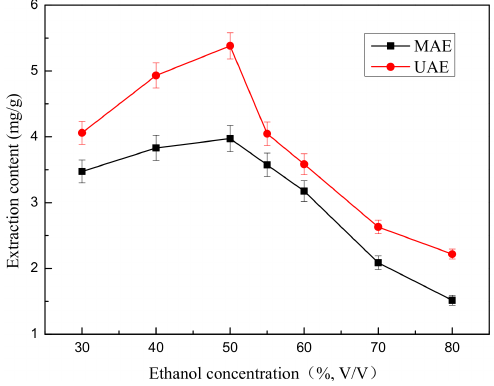
Figure 3. Effect of ethanol concentration on extraction content.